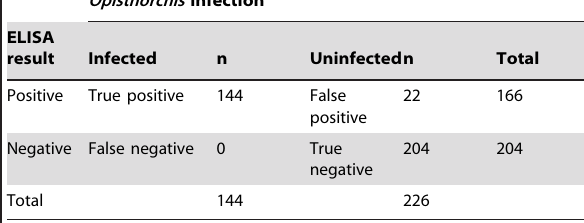
Table 1. Descriptive indices of ELISA results to detect anti- Opisthorchis IgG in sera from persons with a confirmed diagnosis of opisthorchiasis (infected), and from healthy persons (non-infected).